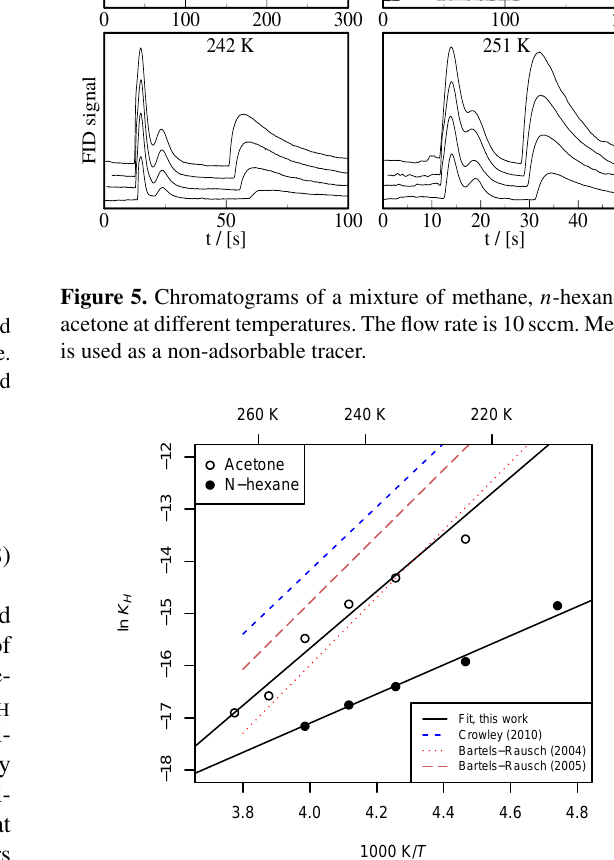
Figure 6. Van’t Hoff plot of ln K H vs. inverse temperature for adsorption of acetone and n -hexane on ice using a methylsilyl- deactivated fused silica column. The solid lines are fits of the data to Eq. (18), used to derive adsorption enthalpies. Van’t Hoff plots of acetone from Bartels-Rausch et al. (2004a, b) and Bartels-Rausch et al. (2005) and recommended values from Crowley et al. (2010) extrapolated from lower temperatures to the temperature range in- vestigated are shown for